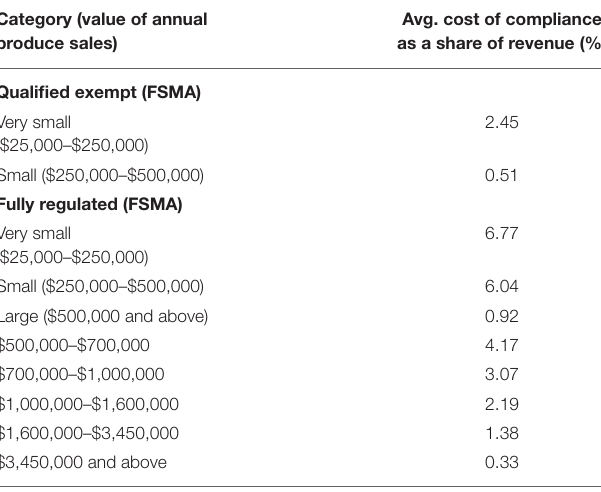
Table reproduced from Bovay et al. (2018), p.